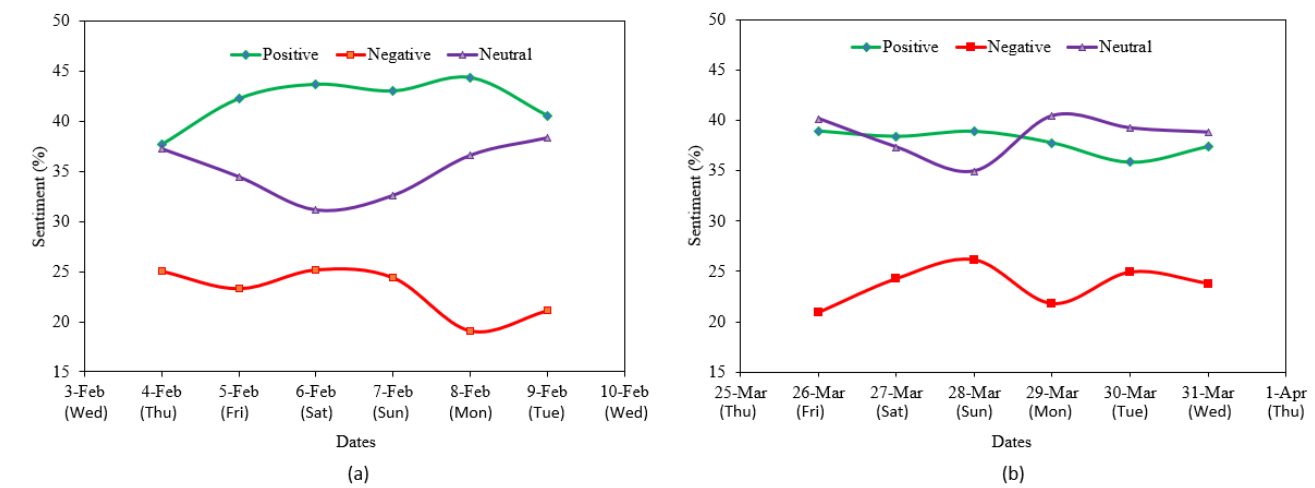
Figure 5. Temporal sentiment towards vaccines from tweets extracted in ( a ) the first week of February 2021 and ( b ) the last week of March 2021.